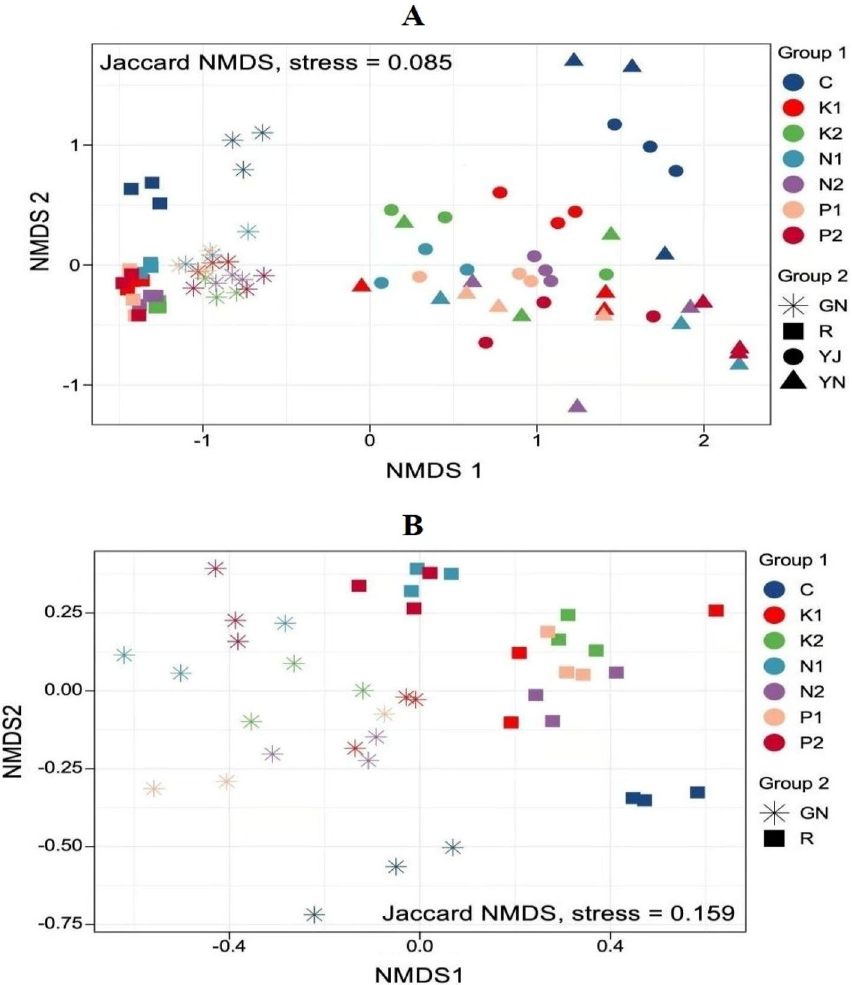
Figure 7. NMDS analysis of β-diversity of bacterial community structure of rice in different ways of rice straw returning (Figure ( A ) shows NMDS analysis of bacterial community structure of rice at tillering stage, Figure ( B ) shows NMDS analysis of bacterial community structure of rice at maturity stage; ( C ) in the figure represent the sample under conditions of no rice straw, that is, the control; K1 and K2 represent 1% and 2% rice straw combined with NK fertilizer; N1 and N2 represent represent 1% and 2% rice straw combined with NPK fertilizer, P1 and P2 represent 1% and 2% rice straw combined with NP